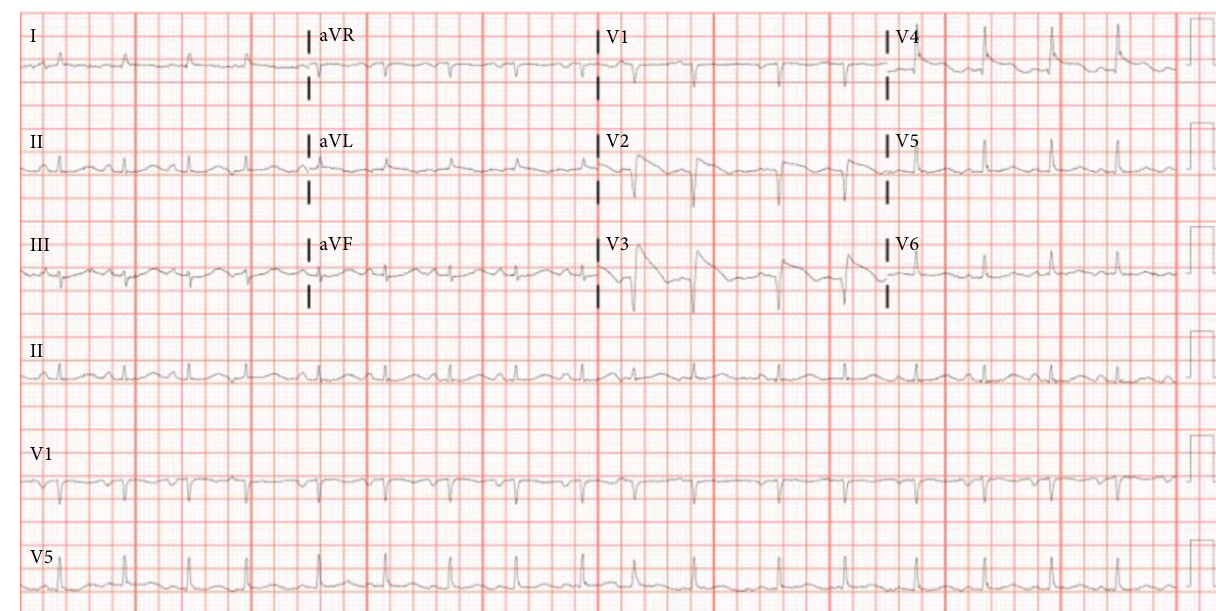
Figure 2: Electrocardiogram on admission day